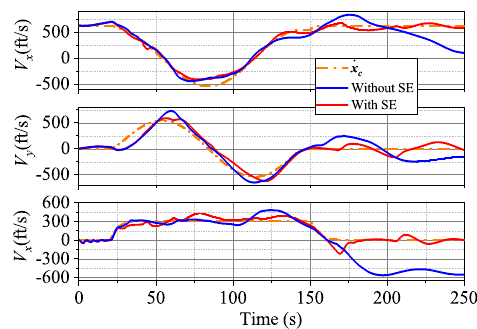
Figure 17. Results for V x , V y and V z